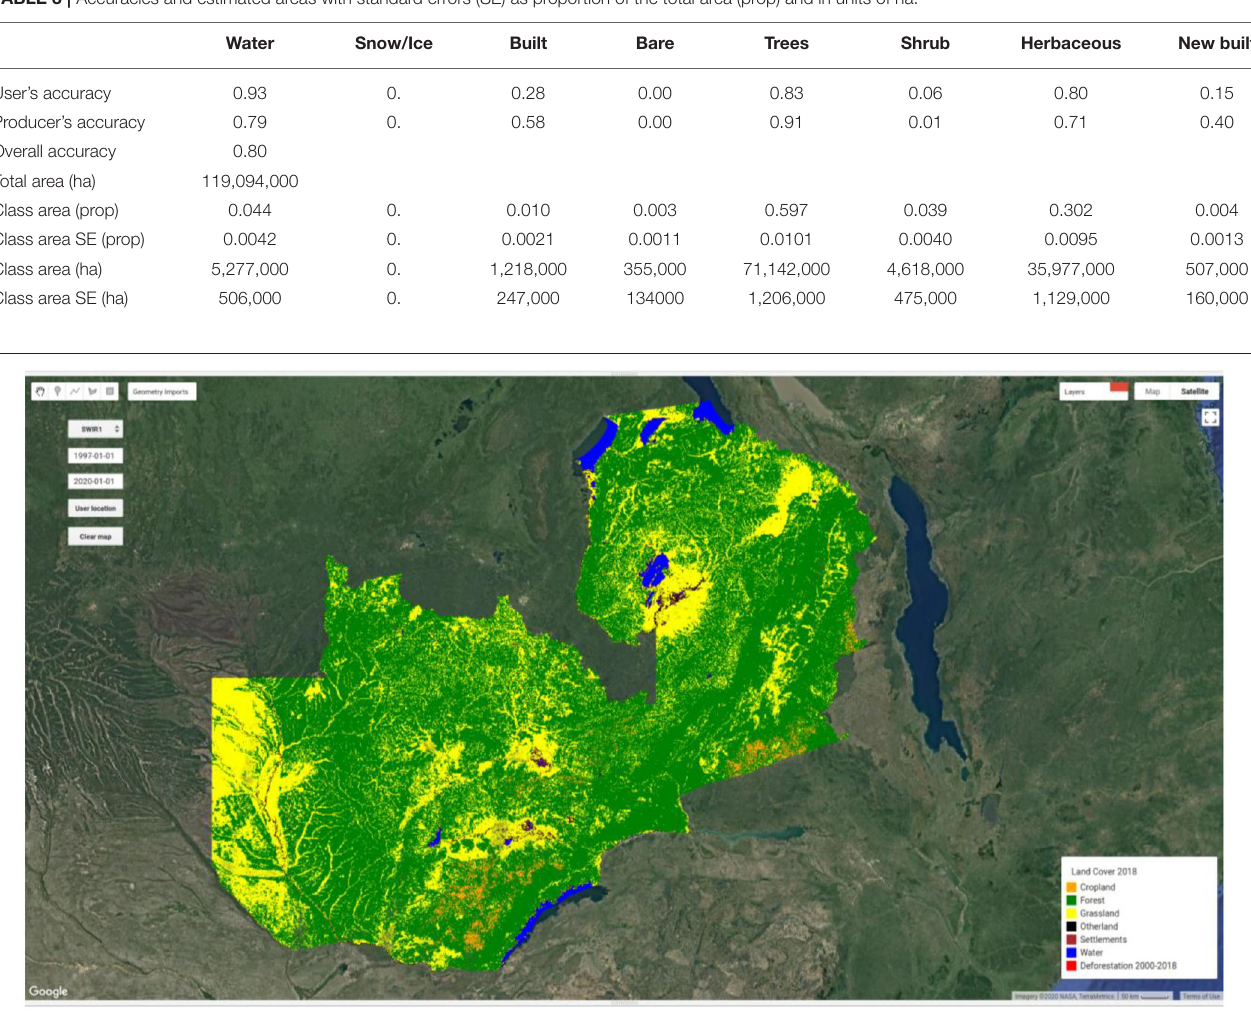
FIGURE 11 | Screenshot of an example land cover and change map of the country of Zambia created iteratively with the tools and functions included in the